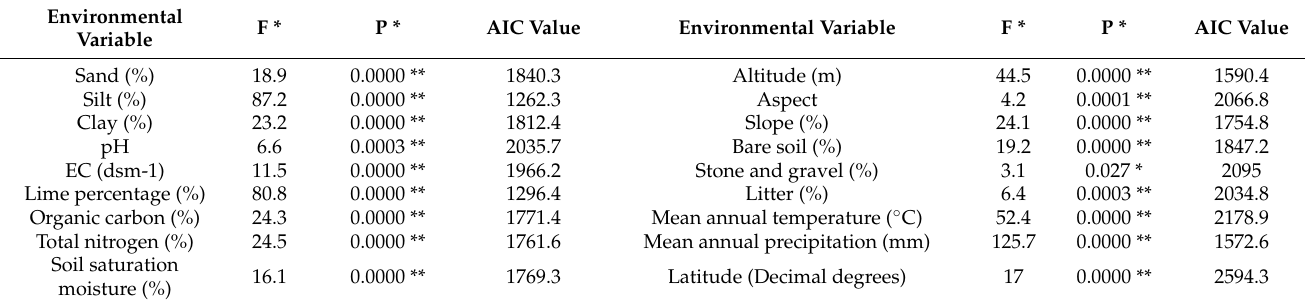
Table 2. The results of the generalized additive model for each of the significant explanatory